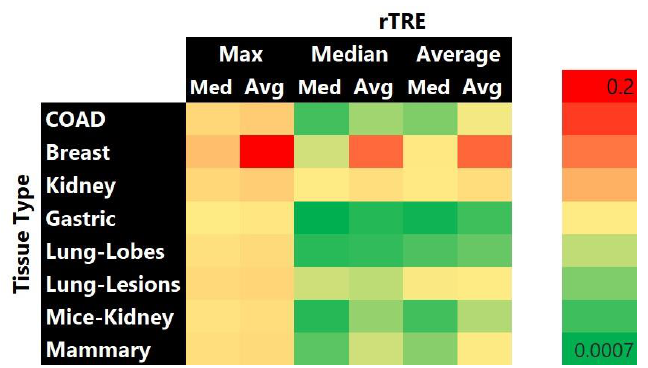
Figure 10. rTRE values for various tissue types for the evaluation data using the approach pro- posed.